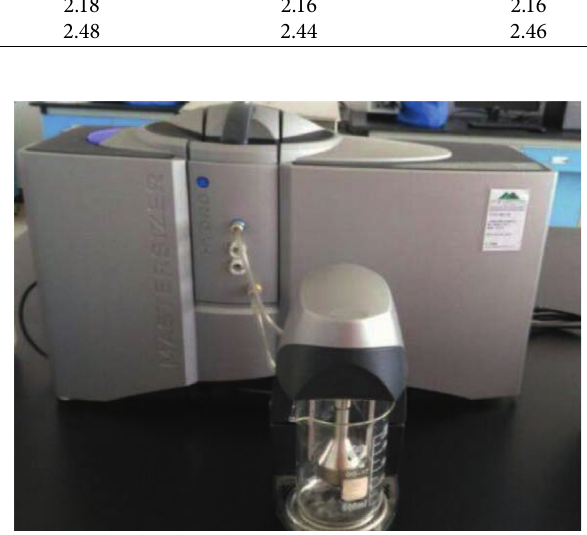
Figure 3: Particle size analyzer. Table 4: Results for particle size measurements of the whole tailings.